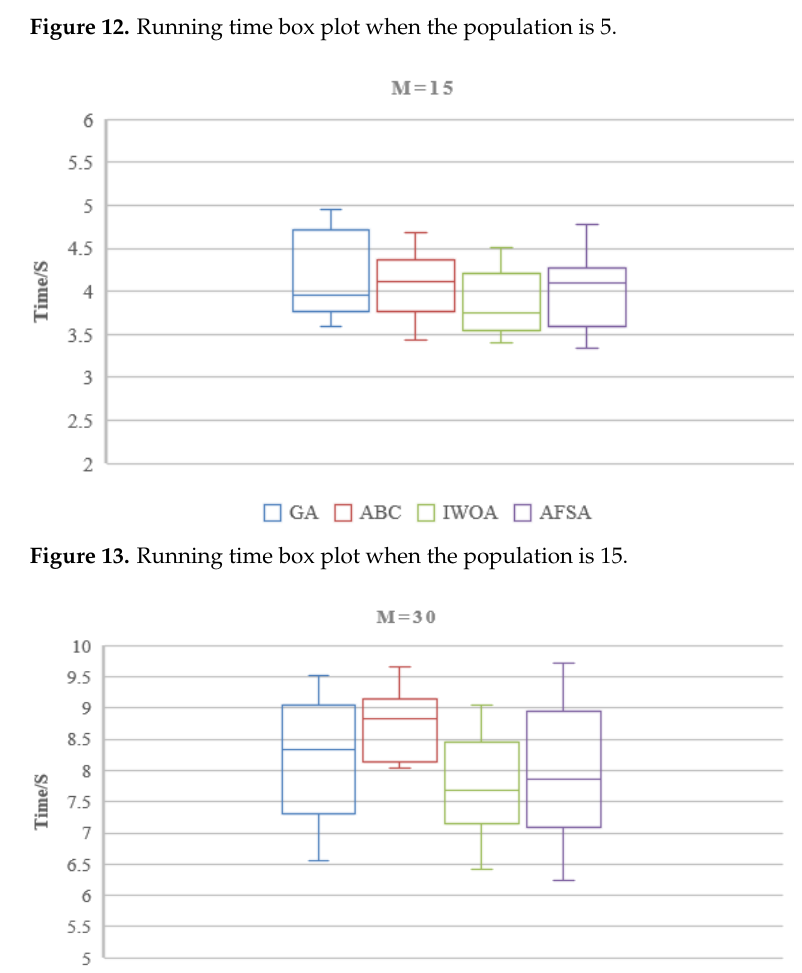
Figure 14. Running time box plot when the population is 30.